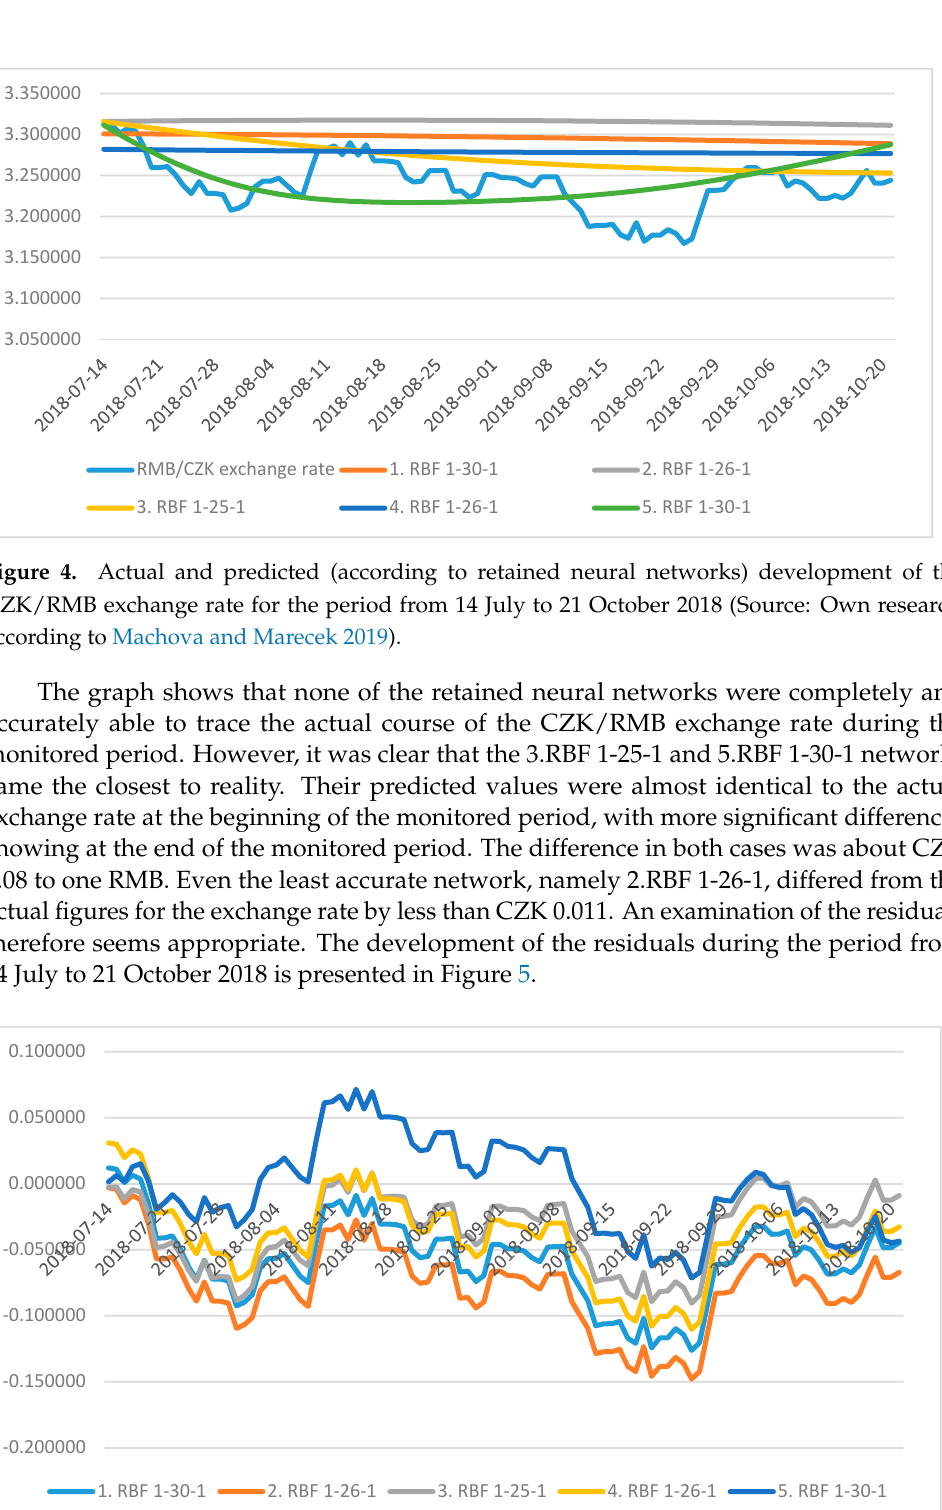
Figure 5. Development of residuals for the equalized time series during the period from 14 July to 21 October (Source: Own research; according to Machova and Marecek 2019).